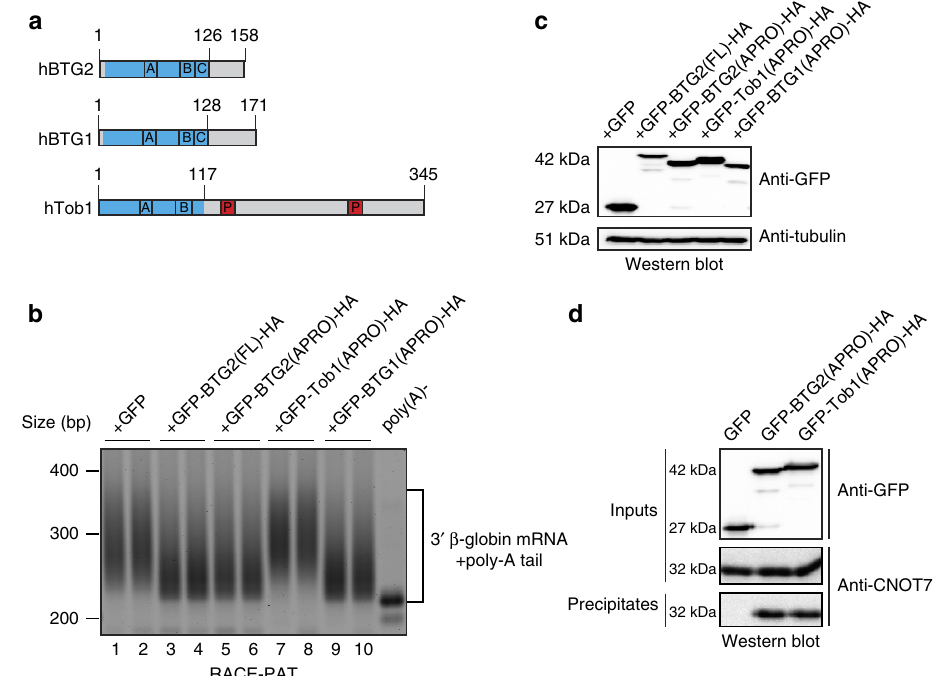
Figure 1 | APRO domains of BTG2 and BTG1 but not of Tob1 are sufficient to stimulate deadenylation of a reporter transcript. ( a ) Schematic organization of human BTG2, BTG1 and Tob1 proteins. APRO domains are highlighted in blue. The conserved boxA (A) and boxB (B) motifs (signatures for the BTG/Tob family), the boxC motif (C; specific for BTG1 and BTG2, see Supplementary Fig. 7) and the PAM2 motifs (P; found in the C-terminal region of Tob1) are indicated. Sequence identity/similarity between hBTG2 and hBTG1 APRO domains are 68.0%/79.7%, respectively, while sequence identity/ similarity between hBTG2 and hTob1 APRO domains are 38.6%/58.3% respectively. ( b ) Reverse transcription polymerase chain reaction amplification of the poly(A) tails of the b -globin reporter transcript. HEK293 Tet-Off cells were co-transfected with plasmids expressing the b -globin reporter and the different HA-tagged BTG/Tob GFP fusion proteins (or empty GFP expression vector). Fragments comprising B 200bp of the 3 0 end of the b -globin mRNA in addition to poly(A) tails were amplified using a RACE-PAT assay. An RNA sample treated with oligo(dT) and RNase H was used as a control for deadenylated b -globin mRNA (poly(A)-). Experiment was repeated twice with two biological duplicates. Quantification of the gel gave an estimated average poly(A) tail length (mean ± s.d., n ¼ 2) of 74.8 ± 1.6, 43.3 ± 1.1, 46.8 ± 3.7, 79 ± 3.4 and 37.4 ± 0.2 nucleotides in cells expressing GFP, that corresponded to the transfections performed in b is shown to demonstrate expression of the GFP fusion proteins. ( d ) Co-immunoprecipitation of CAF1 (CNOT7 paralogue) with BTG2 and Tob1 APRO domains. HEK293 cells were transfected with plasmids expressing HA-tagged BTG/Tob GFP fusion proteins or empty GFP expression vector. Proteins were precipitated with anti-HA agarose beads and revealed by western blot with anti-GFP and anti-CNOT7